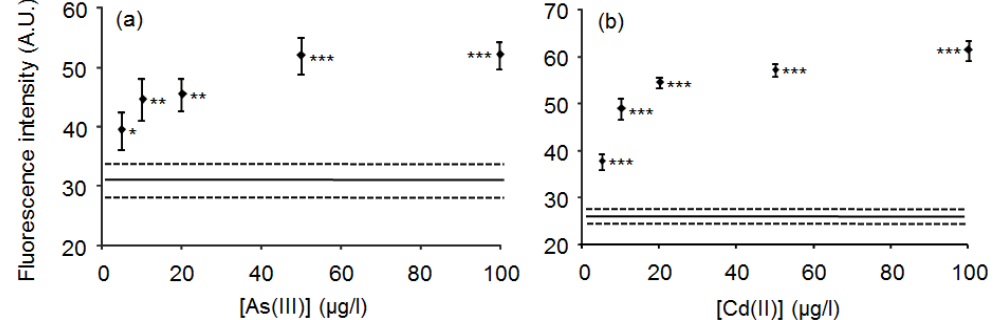
Figure 5. Dose-response relationships between As(III) ( a ) or Cd(II) ( b ) concentration and fluorescence intensity of the lyophilized solid phase biosensors. Fluorescence was measured with fluorometer. A solid line and two broken lines show a mean ± SD of data obtained with ultrapure water. Statistical significance was shown as * p < 0.05; ** p < 0.01; *** p <